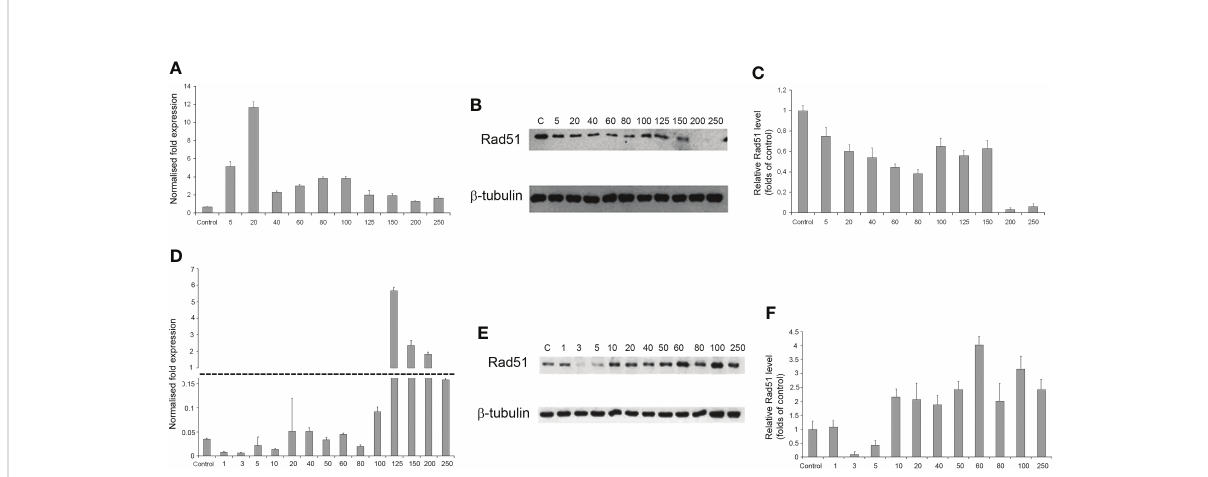
FIGURE 7 The dependence of RAD51 mRNA and protein levels on radiation dose in GO1 (A – C) and Sus\fP2 (D – F) glioblastoma cell cultures. (A, D) mRNA expression; (B, E) Western blotting; (C, F) Quanti fi cation RAD51 protein levels by